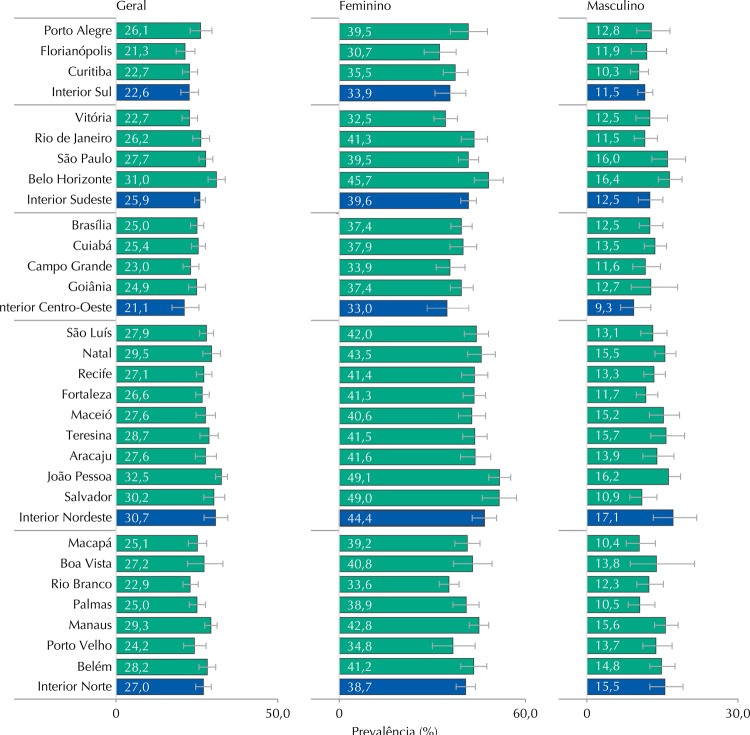
Prevalência de nenhuma atividade física (zero min/semana) em adolescentes das 27 capitais brasileiras (barras verdes) e conjunto dos municípios com mais de 100 mil habitantes, não capitais das regiões, por sexo. ERICA, 2013-2014.